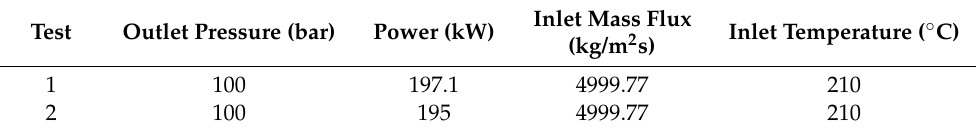
Table 9. 2 × 1 initial and boundary conditions FLOCAL developer